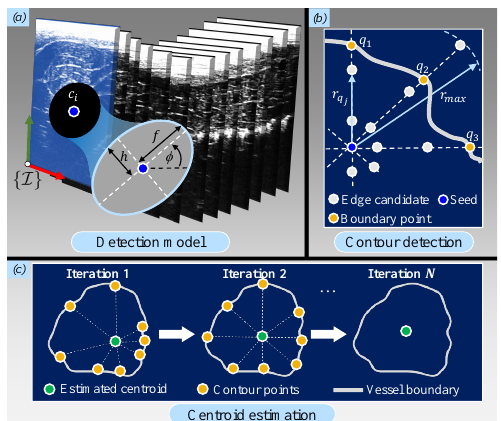
Figure 4. Ultrasound (US) image arterial reconstruction scheme. ( a ) For each US image slice, the arterial contours are extracted and reconstructed centroids ( c i ) are estimated. Knowledge of the ellipse parameters ( f , h , and φ ) are required and included in an extended Kalman filter; ( b ) equi-spaced edge candidates along a radial line with maximum predefined length ( r max ). For each candidate ( j ) in line ( q ), the distance to the center along this line is defined as r q ( c ) Each centroid of the US slices is estimated at each iteration ( q ), repeated iteratively, until the calculated center converges to the weighted